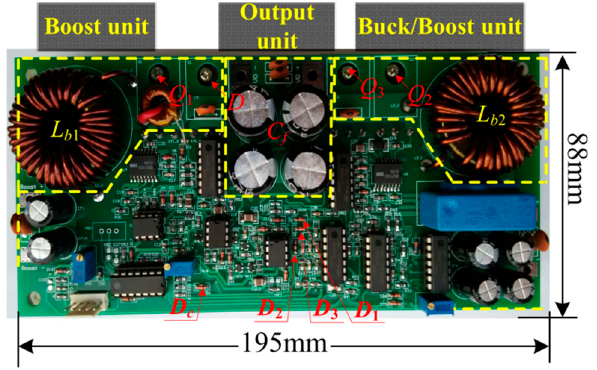
Figure 8. Picture of the prototype.